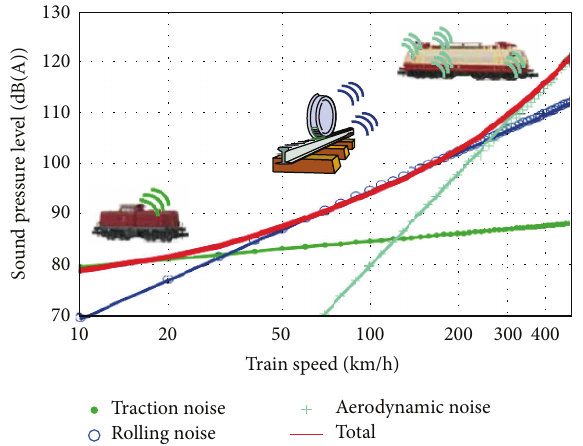
Figure 1: Relative strength and speed dependence of sources of railway noise [2].